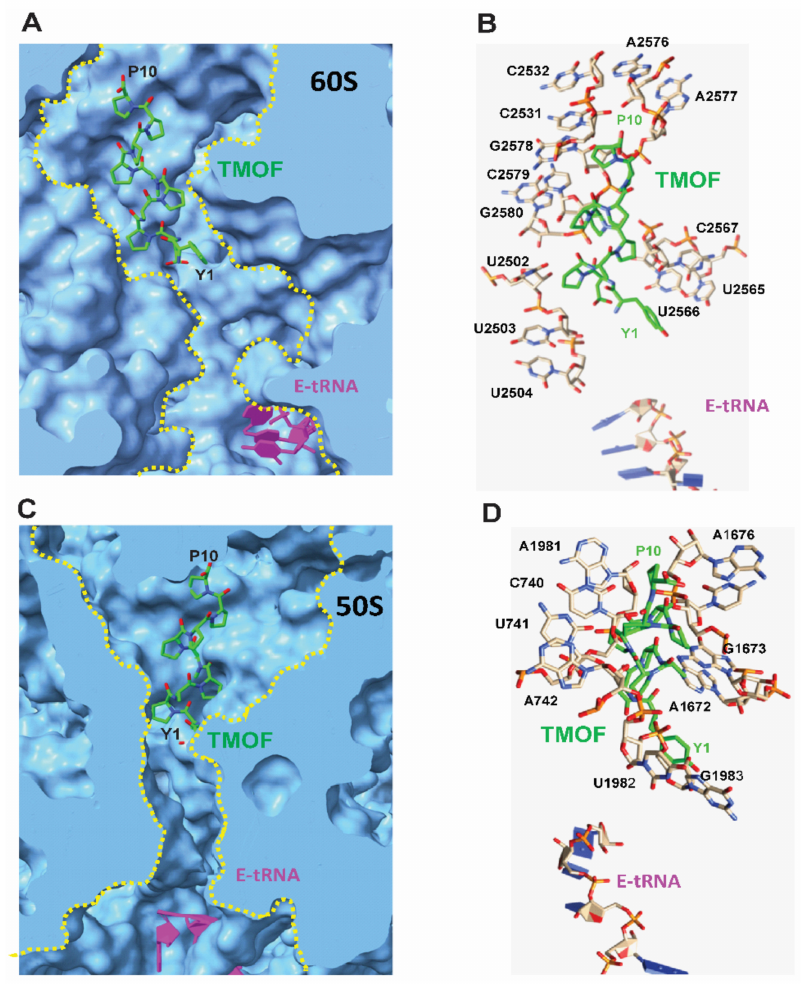
Figure 6. ( A ) Docking of Aea TMOF (colored green) to the Drosophila ribosome peptide exit tunnel (yellow dashed line) of the 60S large subunit (colored blue). The E-tRNA is colored magenta. ( B ) Cartoon showing the nucleotide bases of the 28S r-RNA from the 60S subunit that interacts with Aea TMOF via stacking interactions. The E-tRNA is also shown. ( C ) Docking of AeaTMOF (colored green) to the E. coli ribosome showing Aea TMOF (colored green) in the peptide exit tunnel (yellow dashed line) of the 50S large subunit (colored blue). The E-tRNA is colored magenta. ( D ) Cartoon showing the nucleotide bases of the 23S r-RNA from the 50S subunit that interacts with Aea TMOF via stacking interactions. The E-tRNA is also